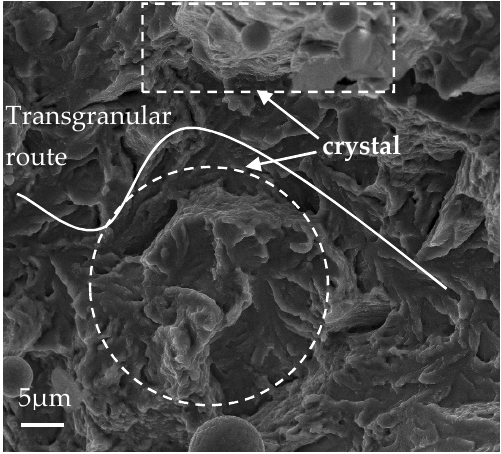
Figure 13. Mesoscopic morphology of transgranular fracture.